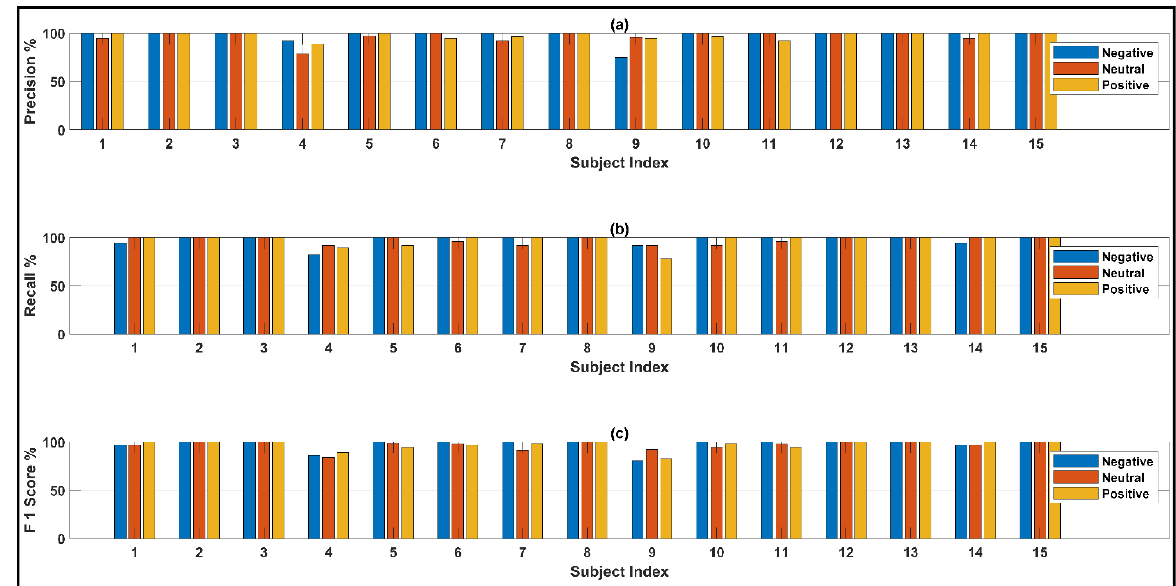
Figure 13. Subject wise 5-fold cross-validation accuracy from MUSIC feature space.